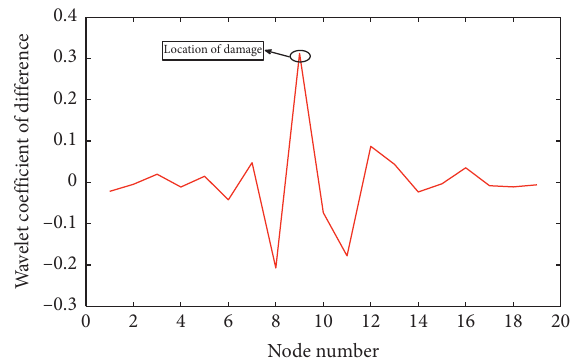
Figure 20: Wavelet coefficient difference for 10% damage in section 10.